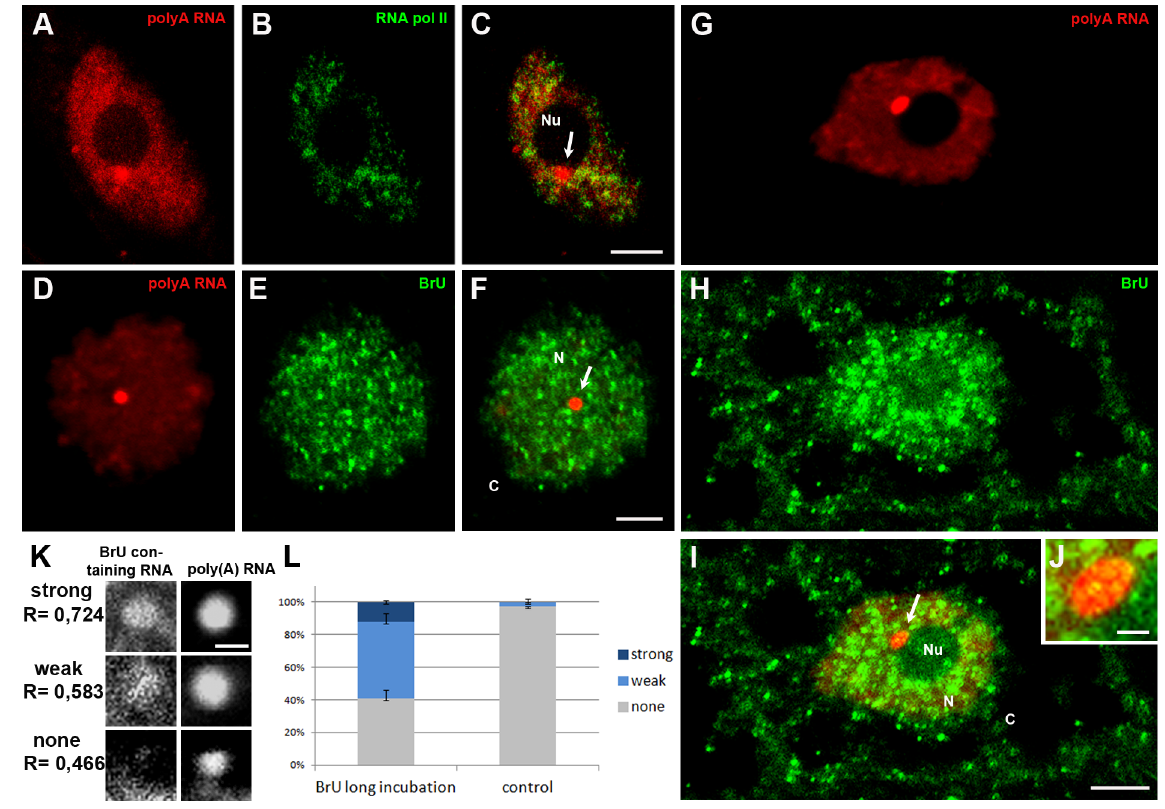
Figure 5. Double labelling of poly(A) RNA (A) and the elongation form of RNA polymerase II (B) in Lupinu root cells. Cajal body (arrow) rich in poly(A) RNA near the nucleolus do not colocalise with RNA polymerase II. Double labelling of a newly formed transcript (E, H) and poly(A) RNA (D, G) in lupine cells. If the transcript does not leave the nucleus, no signal occurs in the CB (arrow) (D–F). In cells in which the newly formed RNA is transported to the cytoplasm, a weak signal is observed in the Cajal body (arrow) (G–I). Bar, 5 m m. Fragment of the nucleus from Fig 2I (J). BrU- containing RNA localises at the periphery and in small spots in the middle of CB (J). Bar, 1 m m. The percentage of Cajal bodies rich in poly(A) RNA that colocalise with BrU-containing RNA (K, L). The data for experimental treatments and control were conducted, analyzed and plotted as in Figure 2G–H. A scale bar representing 2 m m is shown. Error bars represent standard error. N- nucleus, Nu- nucleolus, C- cytoplasm.